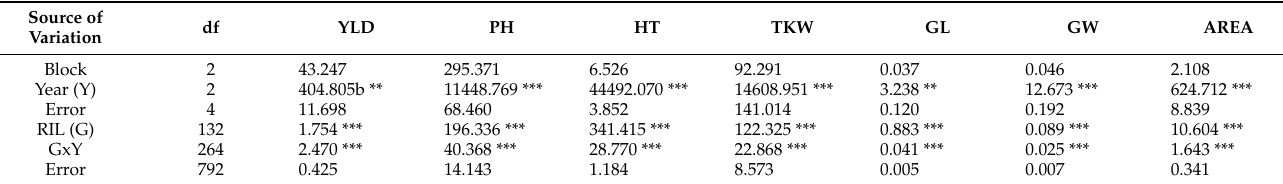
Table 1. Mean squares from the combined analysis of variance of grain yield (YLD), plant height (PH), heading time (HT), thousand kernel weight (TKW), grain length (GL), grain width (GW), grain area (AREA) in the Liberdur x Anco Marzio recombinant inbred line (RIL) mapping population evaluated at Valenzano (Bari, Italy) for three years. Source of Variation df YLD PH HT TKW GL GW AREA Block